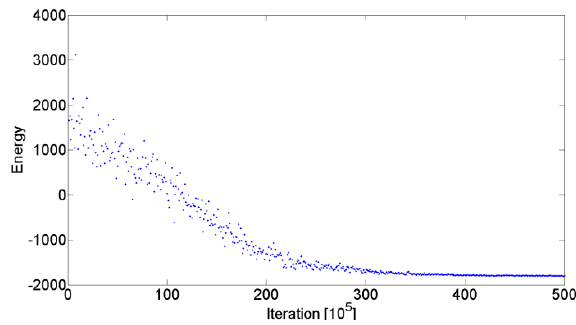
Figure 6: The energy decreases during the optimization process and converges after 30 million